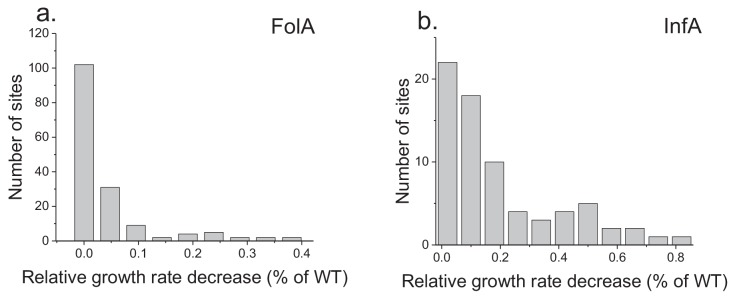
Distribution of average fitness effects of amino acid substitutions.The panels show the distribution of average growth defects due to amino acid substitutions across FolA (a) and InfA (b) protein sites. The average growth (fitness) effects at each site was calculated as the mean values of experimentally measured growth phenotypes due to all possible amino acid substitutions at the site.